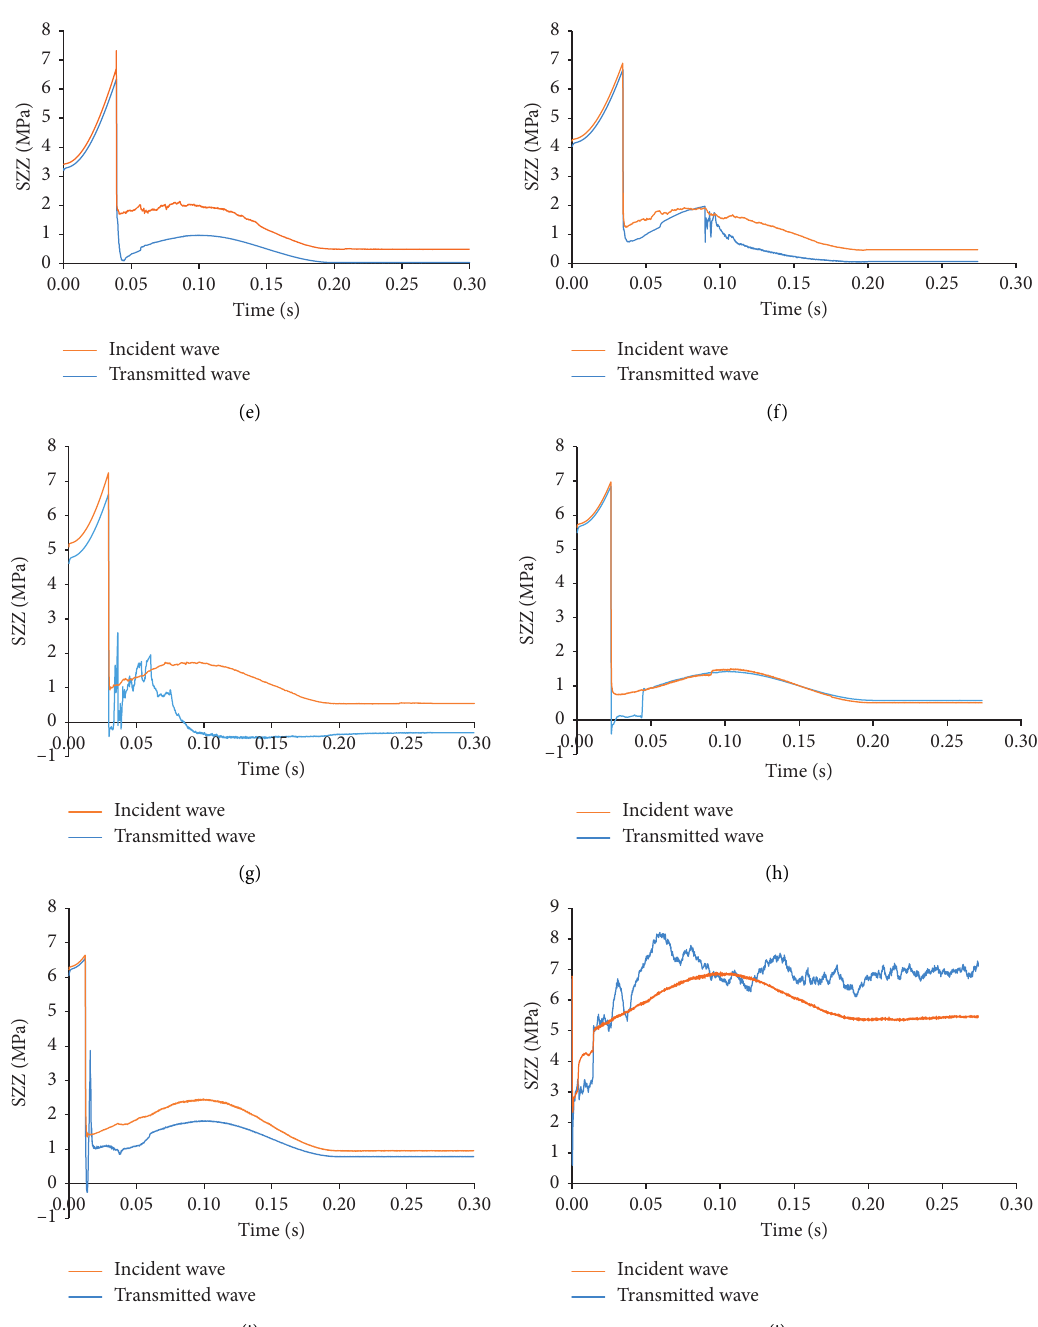
Figure 11: Waveform of the incident and transmission for the model with different LP. From Figures 11(a)–11(j), the LP is from 10% to 100%, respectively. (a) C , (b) LP � 20%, (c) LP � 30%, (d) LP � 40%, (e) LP � 50%, (f) LP � 60%, (g) LP � 70%, (h) LP � 80%, (i) LP � 90%, and (j) LP � Figure 14. With increasing dynamic disturbance intensity, the peak incident wave stress increases from 2.33 MPa to 4.02 MPa and the peak transmitted wave stress increases